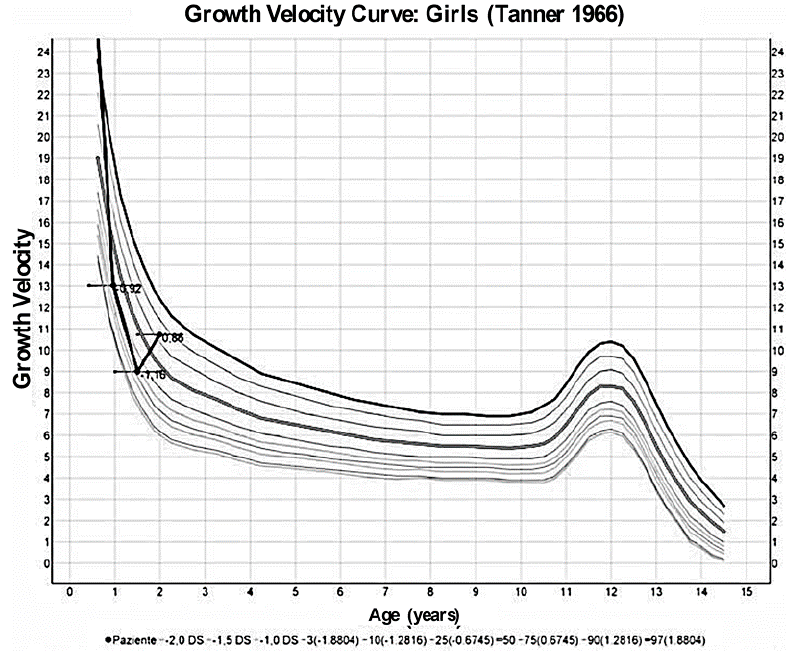
Children 2020 , 7 , x FOR PEER REVIEW 7 of 13 Direct sequencing of the HSD11B2 gene by Sanger revealed a homozygous frameshift variant ff erent ages. in exon 5, c.900 dup, p. Glu301Argfs*56. Analysis of the parents showed that both were Figure 4. Growth velocity curve by Tanner 1966 [14] of the patient at different ages. Figure 4. Growth velocity curve by Tanner 1966 [14] of the patient at di